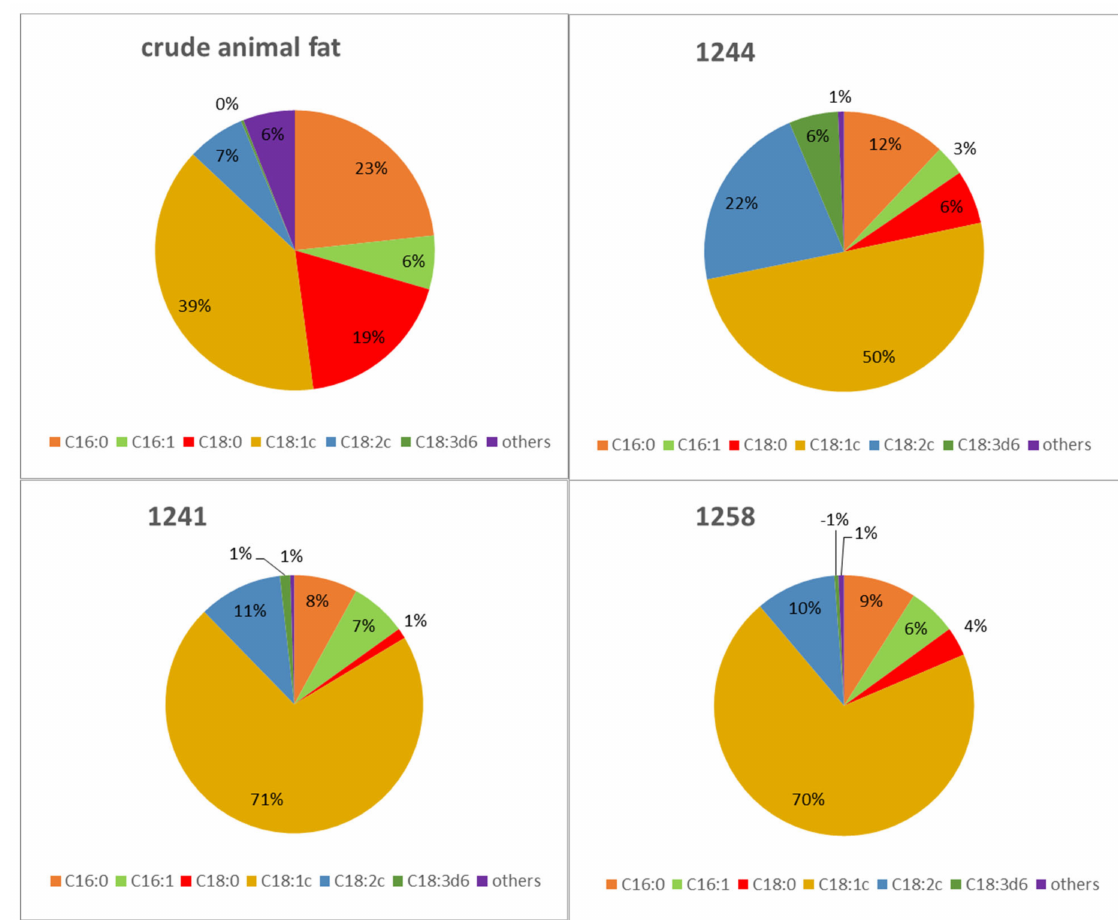
Figure 7. Conversion of crude animal fat to others lipid metabolites by selected Metschnikowia strains (cultivated on crude fat medium with a C/N of ratio 150) Legends: (1244) Metschnikowia sinensis 1244 , (1241) Metschnikowia andauensis 1241 , (1158), Metschnikowia chrysoperlae 1158. C16:0-palmitic acid; C16: 1-palmitoleic acid; C18:0 - stearic acid; C18: 1-oleic acid; C18: 2-linoleic acid; C18: 3- α -linolenic